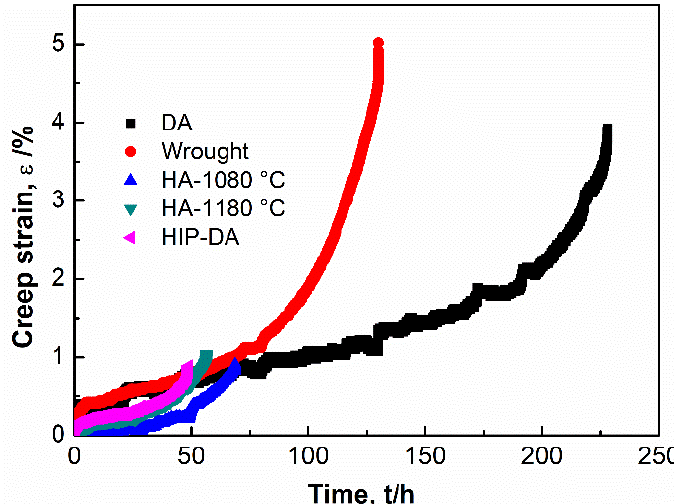
Figure 3. Creep lifetime-creep strain curves of L-DED heat-treated variants compared to the conventional wrought sample at 650 °C/700 MPa.